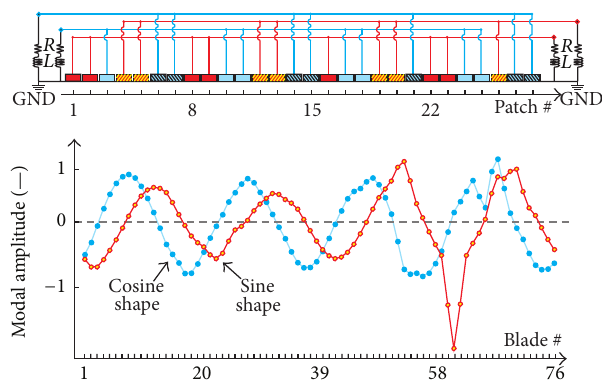
Figure 16: Below: shape of the drum-dominated mode D4 with 𝑛 = 4 nodal diameters (sine and cosine modes). Above: electrical connections of the PZT patches in 4 independent loops for the parallel shunt (all PZT patches of the same color are connected in parallel).